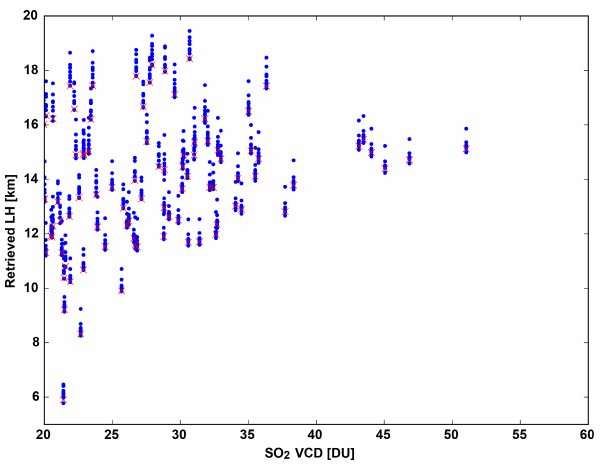
Figure 5. Dependency of the retrieved SO 2 LH on the TROPOMI instrument row. The SO 2 LH as a function of the SO 2 VCD is shown for the Sinabung eruption. Blue dots show the SO 2 LH re- sult for every 50th detector row, whereas red crosses show the LH interpolated to the measurement